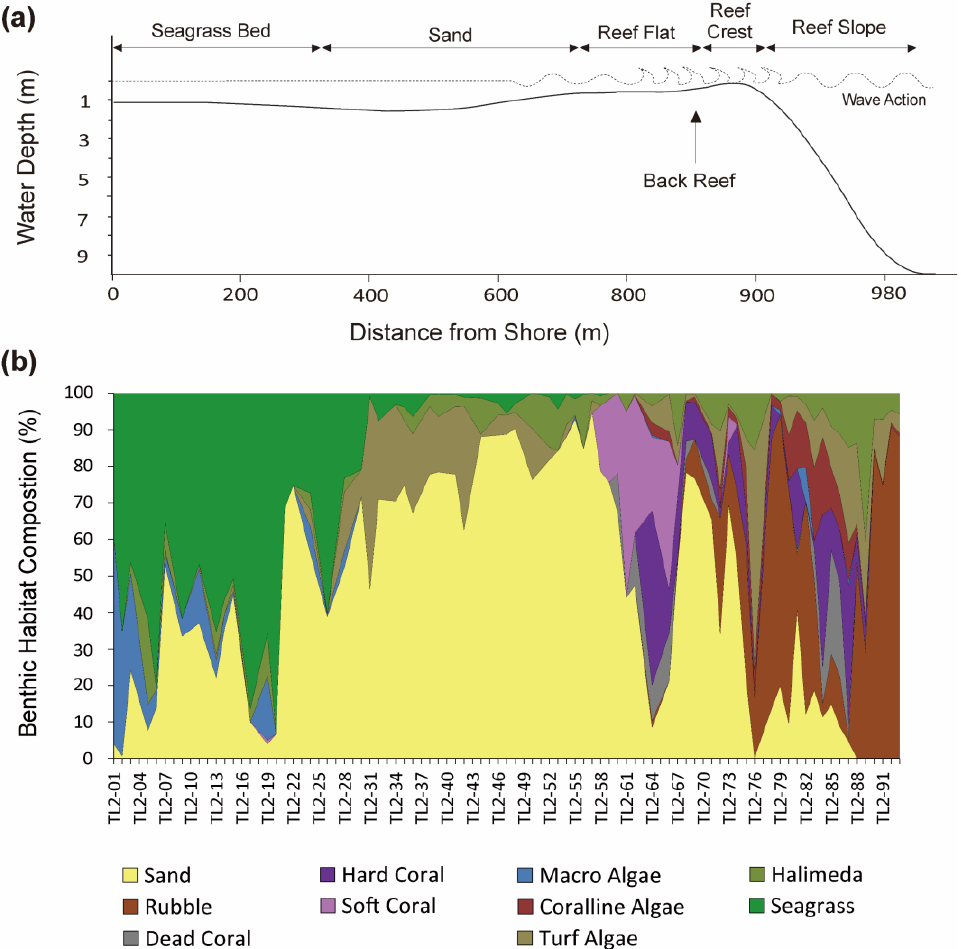
Figure 7. Benthic habitat evaluation results for the second transect line (TL-2). ( a ) Depth profile and topographical zonation from the shoreline to the reef edge. ( b ) Benthic habitat composition of the 93 sampling points (i.e., photo-quadrats) along TL-2.